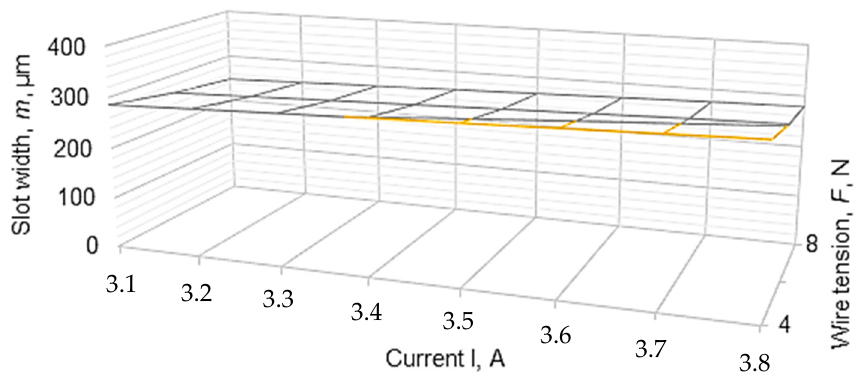
Figure 9. The influence of the average current I and the average voltage F on the width of the slot in the middle of the thickness of the blank ( H = 20 mm, T on = 12 µ s, T off = 30 µ s, v = 2500 mm/min, U = 135 V).